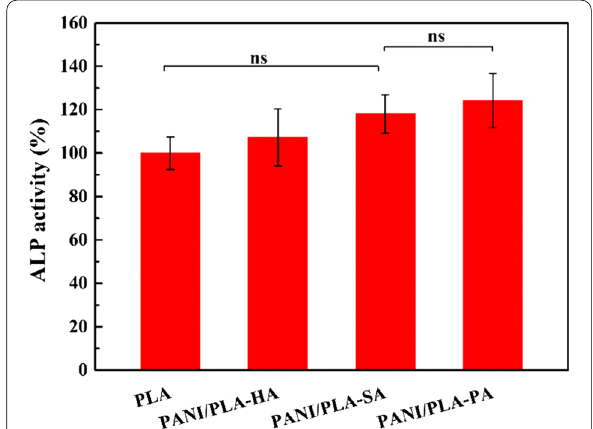
Fig. 12 Alkaline phosphatase activity on PANI/PLA composite nanofibers scaffolds (ns no =